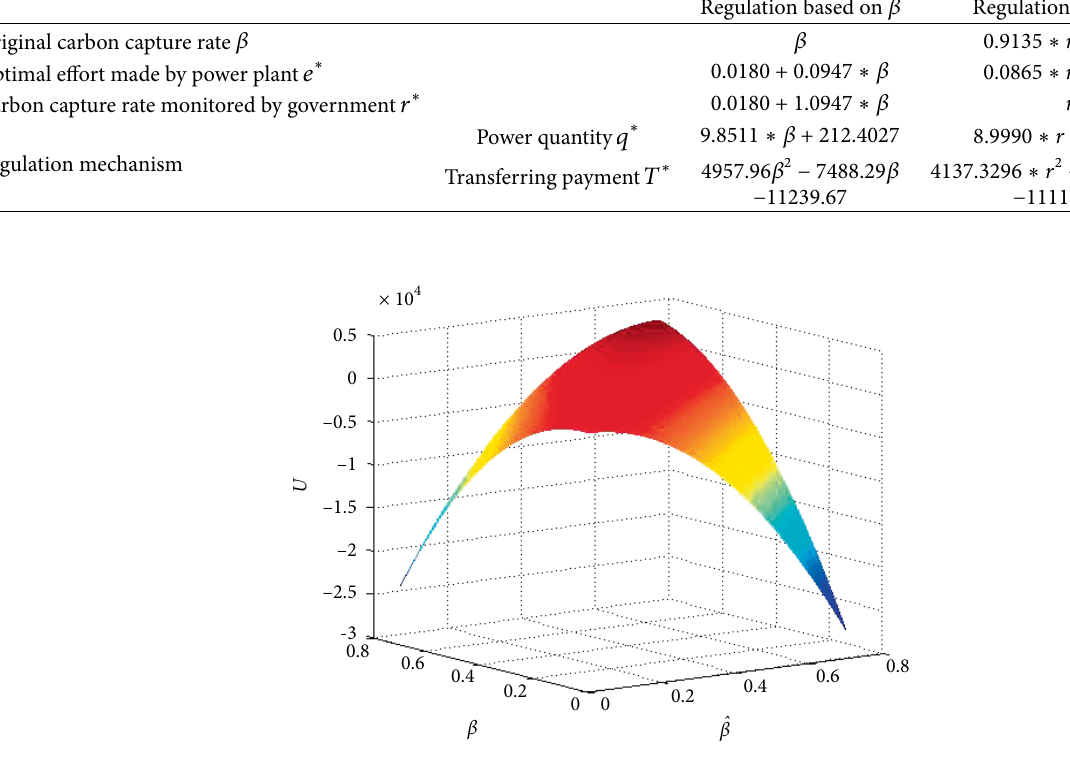
Figure 2: Figure of 𝑈 varying with β and ̂훽 .